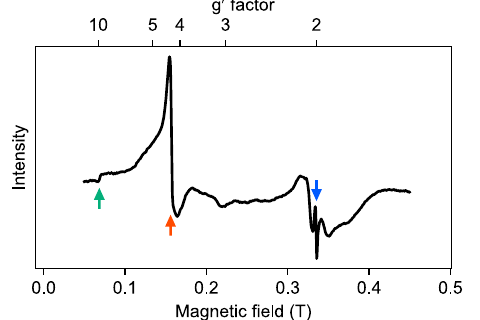
Fig. 3 Result of electron spin resonance (ESR) spectroscopy of neurons measured with a conventional X-band ESR spectrometer. The temperature of the sample is fi xed at 10 K. Green, red, and blue arrow indicate ESR signals corresponding to g 0 ¼ 9.8, 4.3, and 2.0, respectively. It should be noted that the shape of the spectrum is derivative-like due to the modulated magnetic fi